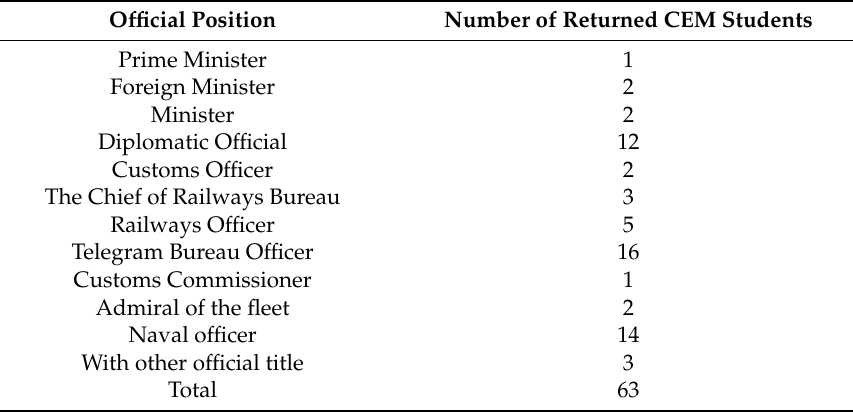
Table 1. Official Positions Held by the Returned CEM Students (in total 99). Official